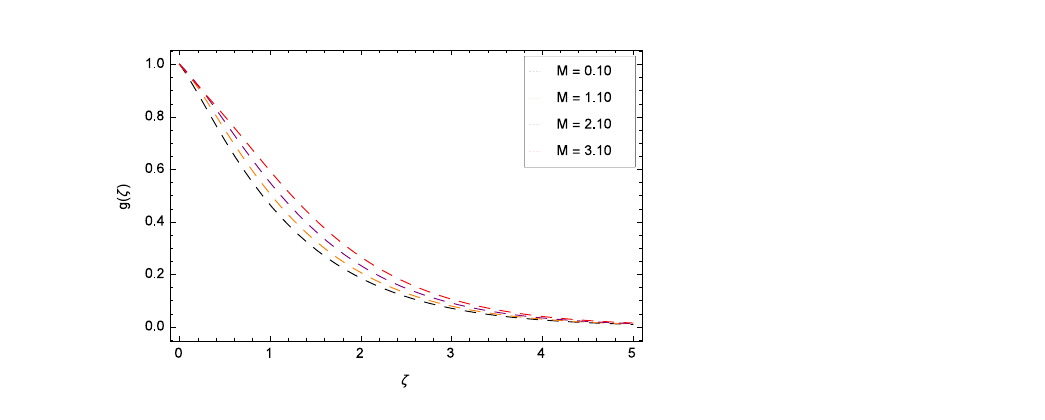
Figure 12. Pattern of graph curves on account of M .